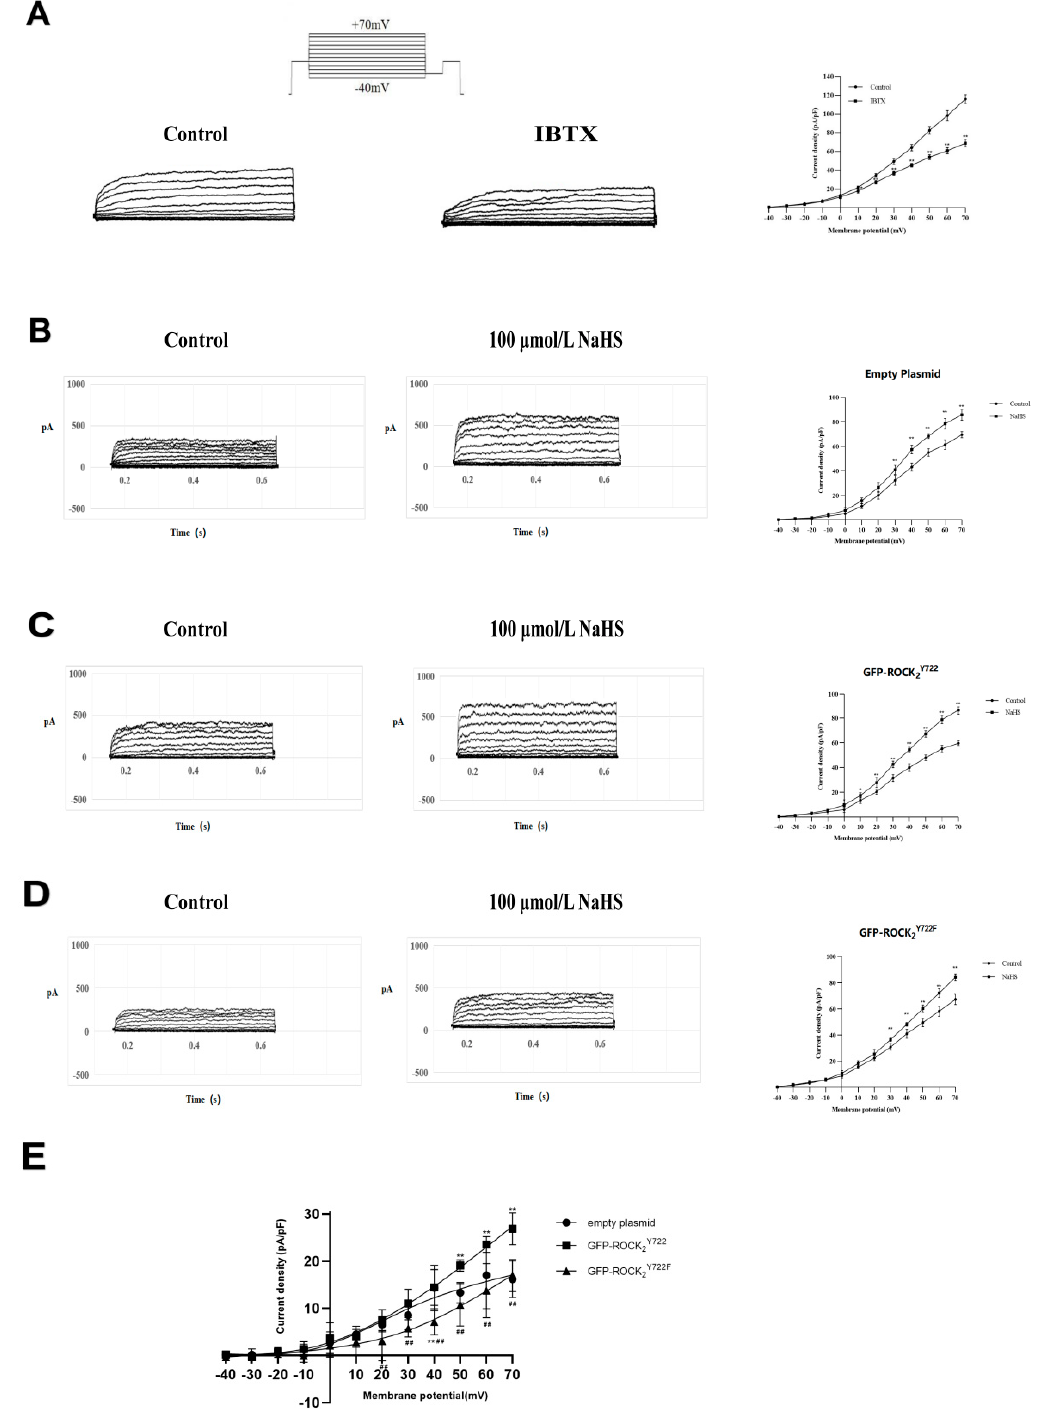
Figure 6. ROCK 2 Tyr722 mediated NaHS-increased current of BK Ca in transfected RHNs (whole − cell patch − clamp recording, mean ± SEM, n = 5). ( A ) The evoked outward current, and effect of IBTX. ( B ) Effect of NaHS on BK Ca current in the empty plasmid group. ( C ) Effect of NaHS on BK Ca current in the GFP − ROCK 2 Y722 group. ( D ) Effect of NaHS on BK Ca current in the GFP − ROCK 2 Y722F group. * p < 0.05, ** p < 0.01 vs. control group. ( E ) NaHS − increased BK Ca currents in